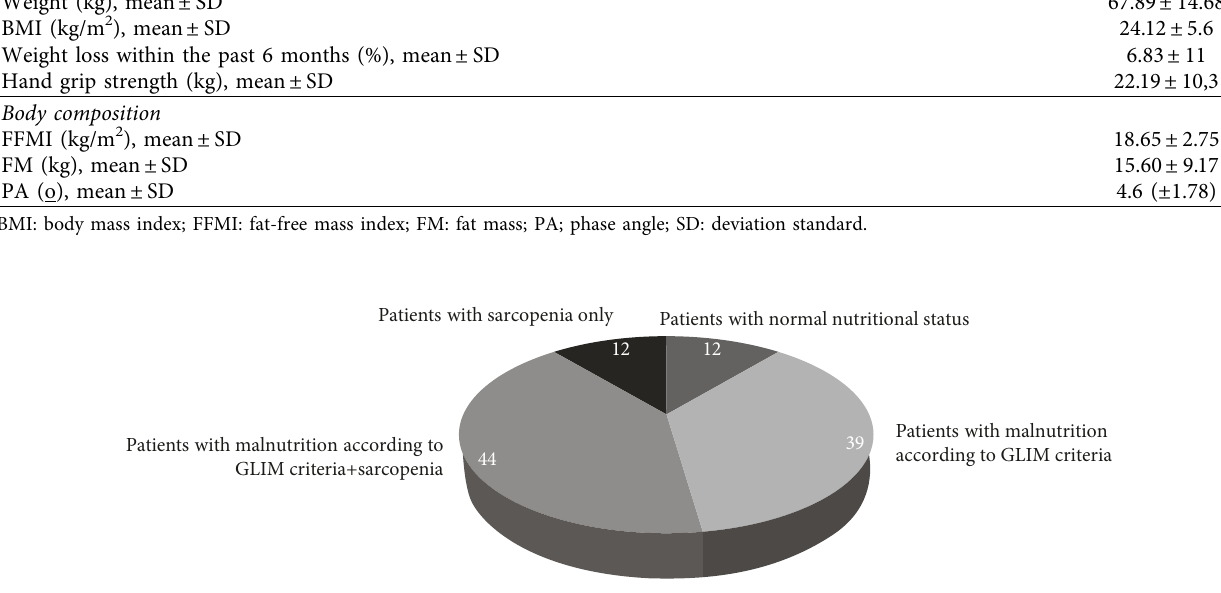
Figure 2: Distribution of study population by nutritional status (malnutrition, sarcopenia, and normal status).